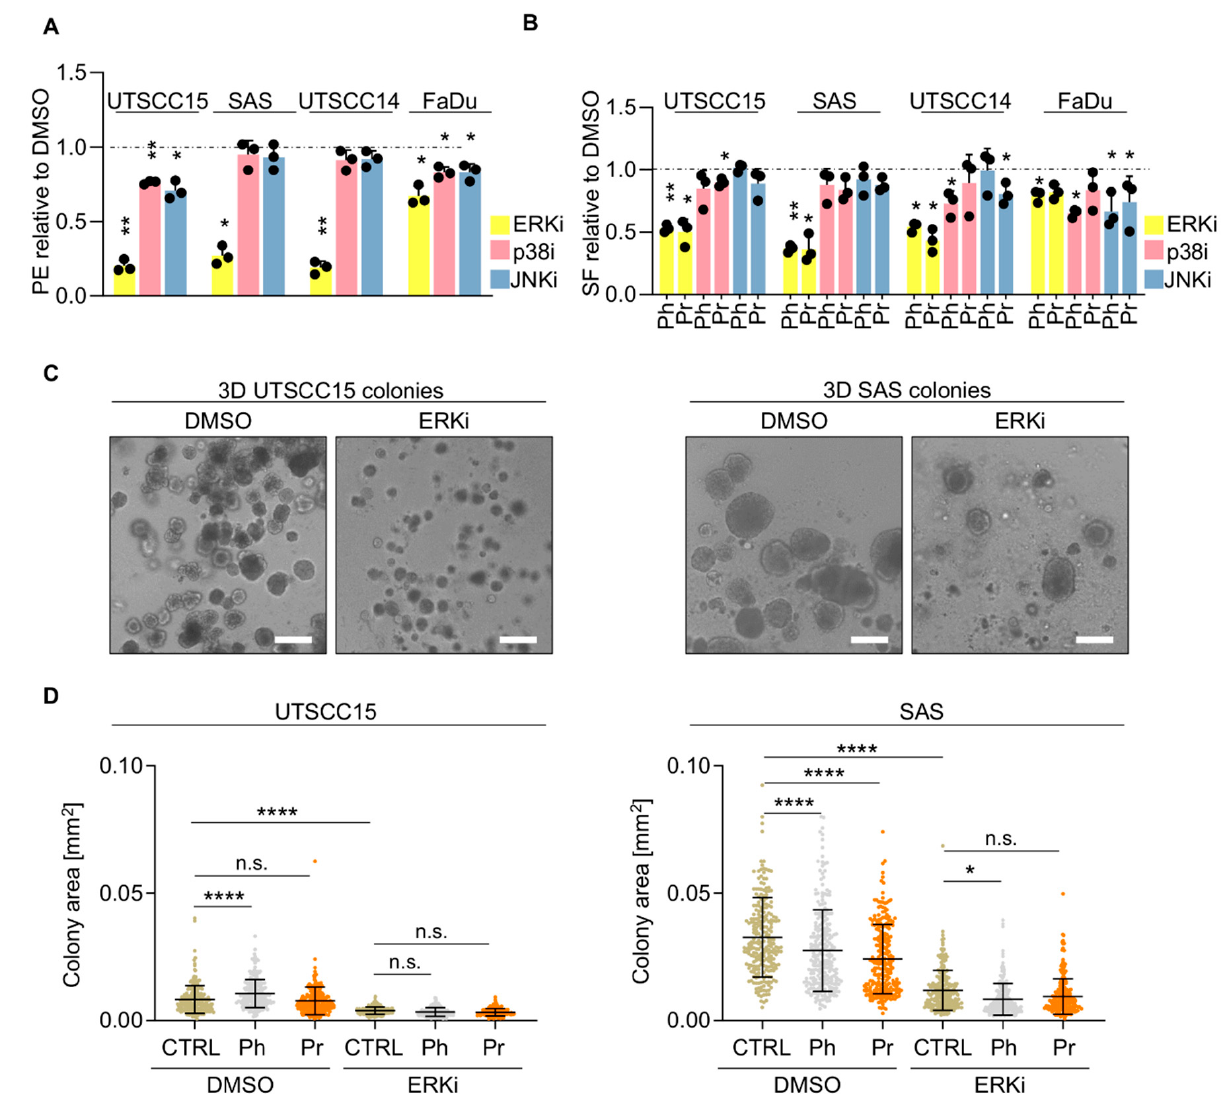
Figure 4. MAPK inhibitors mediate differential radiosensitizing potential in 3D HNSCC cell cultures exposed to photon or proton irradiation. ( A ) Cytotoxic effects of ERKi (Ulixertinib), p38i (Ralimetinib) and JNKi (SP600125) (all at a final concentration of 1 µ M) in 3D cell cultures of indicated cell lines normalized to DMSO controls. ( B ) 3D clonogenic radiation survival of indicated HNSCC cell lines upon pretreatment with indicated inhibitors (all at a final concentration of 1 µ M) normalized to DMSO controls. ( C ) Representative microscopy images of unirradiated 3D UTSCC15 and SAS cell colonies. Scale bar, 200 µ m. ( D ) Colony sizes of 3D lrECM grown UTSCC15 and SAS colonies upon 4-Gy photon or proton irradiation in presence of the ERK inhibitor Ulixertinib. DMSO served as control. Results show mean ± SD ( n = 3; two-sided t -test; * p < 0.05, ** p < 0.01; **** p < 0.0001). PE, Plating efficiency; SF, Surviving fraction; CTRL, control; Ph, photon irradiation; Pr, proton irradiation; n.s., non-significant.